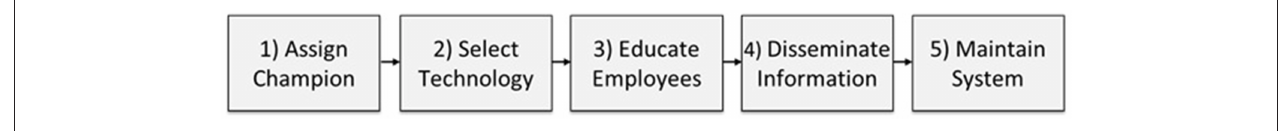
FIGURE 9 | Steps for implementation of work zone intrusion alert systems.